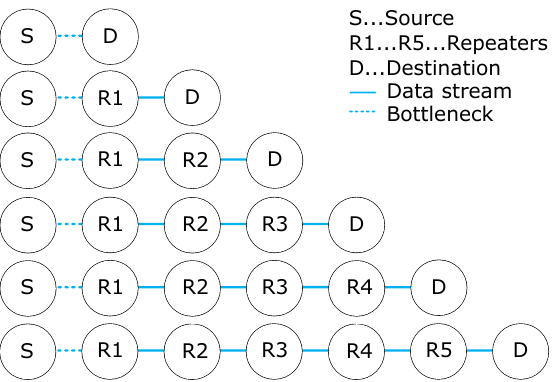
Figure 19. Simulation topology for discovering effects of repeaters and bottlenecks on data